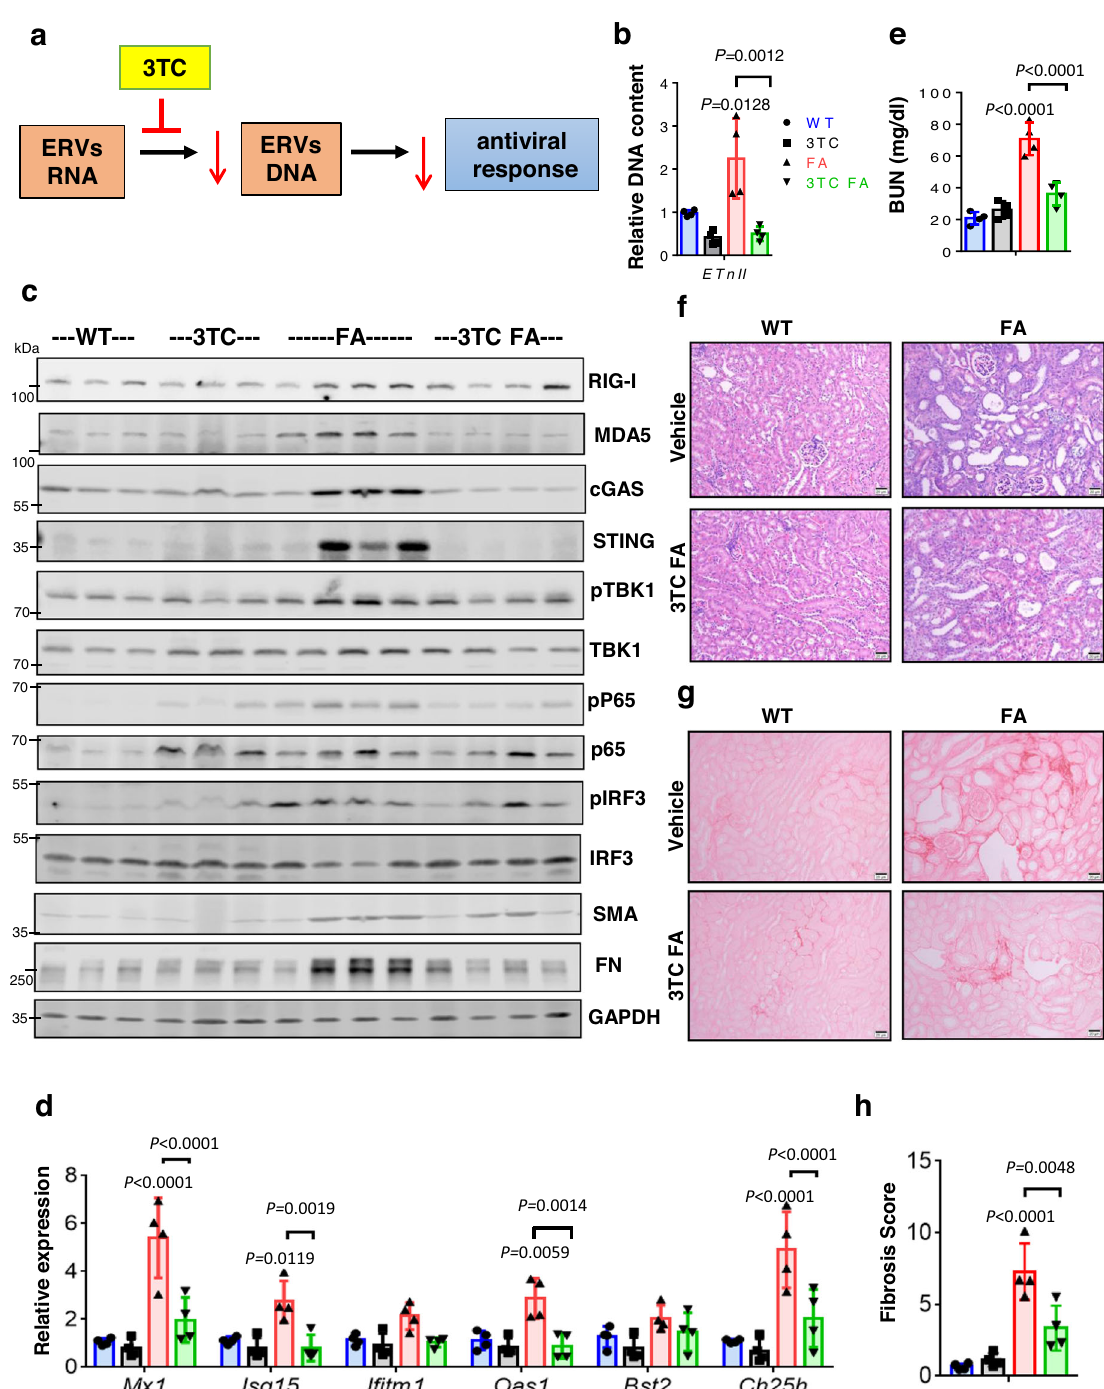
Fig.9 | Antiviral Lamivudine (3TC) treatment protected mice from FA-induced injury. a Experiment design. b ERV DNA content (Etnii) in kidneys of WT and FA mice treated with or without 3TC (WT, blue; 3TC, black; FA, red; 3TC FA, green; n =4ineach). c Westernblotsshowing proteinlevelsof RIG-I,MDA5,cGAS,STING, pTBK1, TBK1, pP65, P65, pIRF3, IRF3, FN, and SMA in kidneys of WT and FA mice treatedwithorwithout3TC.GAPDHwasusedasaloadingcontrol. d RelativemRNA levelofISGs( Mx1,Isg15,I fi tm1,Oas1,Bst2 ,and Ch25h )inkidneysofWTandFAmice treatedwith orwithout3TC ( n =4 in each). e Serum BUN levelsofWT and FAmice treatedwithorwithout3TC( n =4ineach). f RepresentativeimagesofH&Estaining